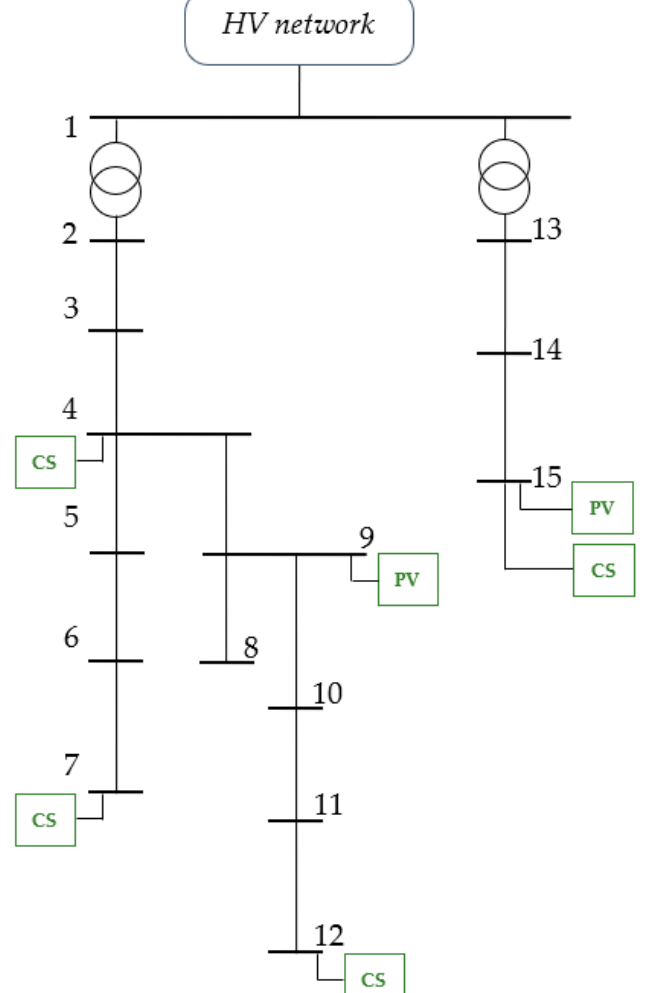
Figure 3. The microgrid under study. Table 1. Load Input